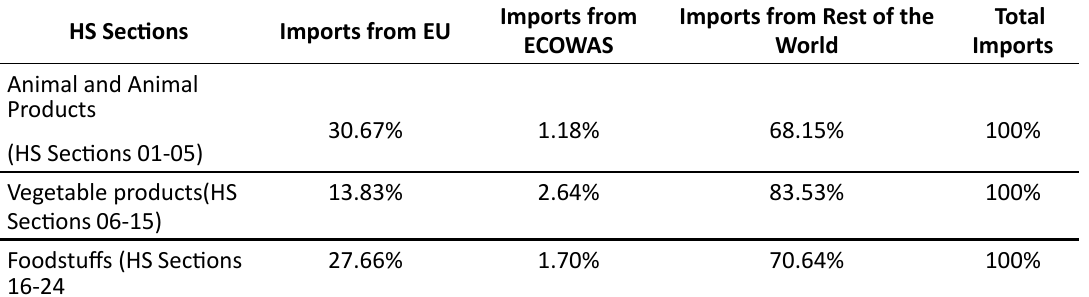
Table 1: Nigeria’s Agric. Product Section Imports at Zero Tariff as % Contribution of Agricul -